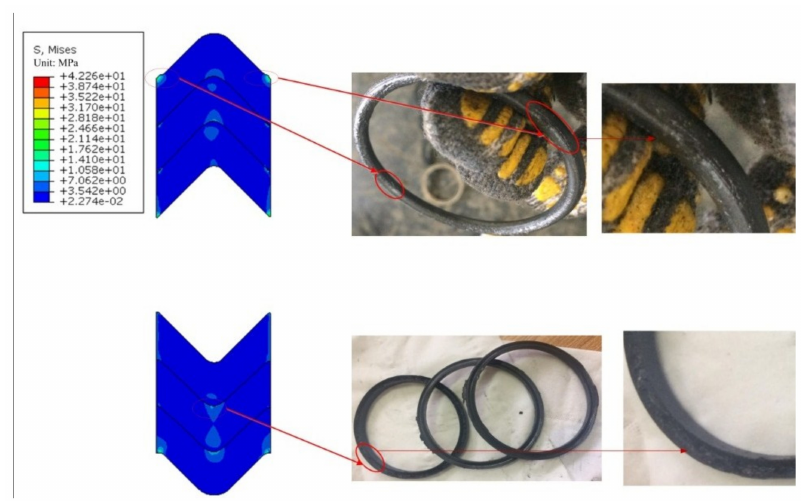
Figure 5. Result of numerical simulation and failures of the V-shaped sealing rings in the